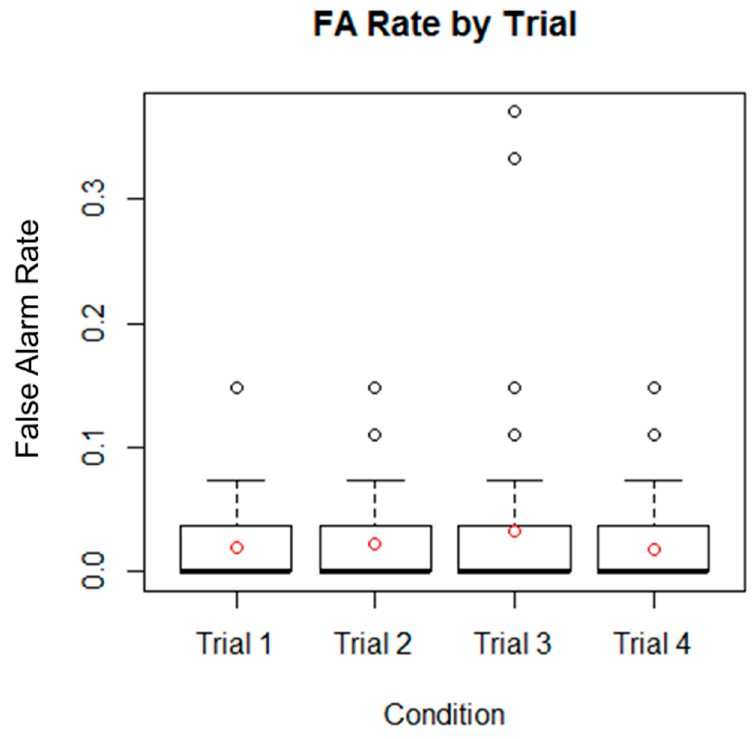
Figure 9. Hit rate by trial.